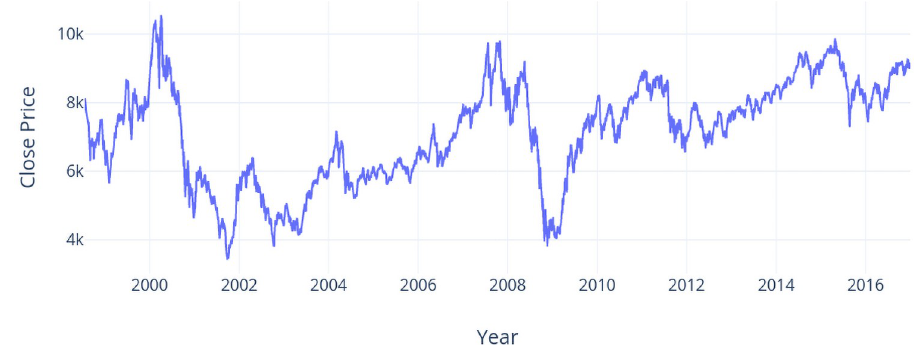
Fig 7. Close prices over years (TX dataset).